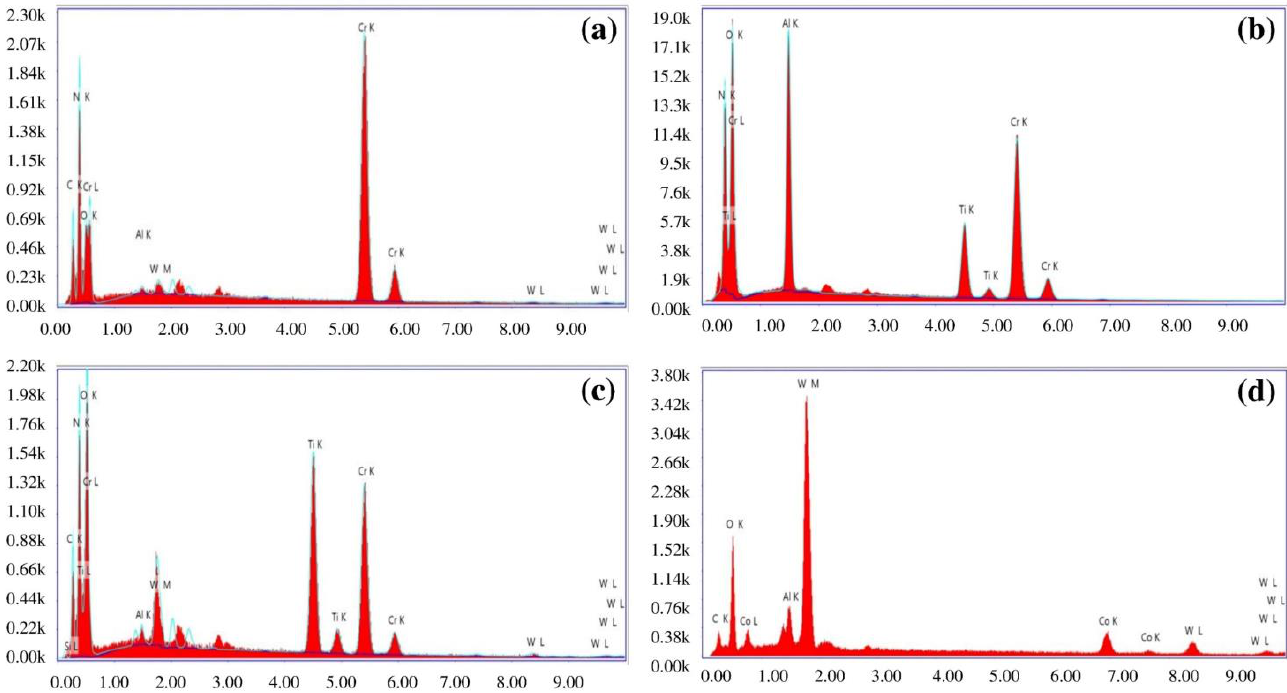
Figure 16. EDS analysis of zones A-D in Figure 15 for different coatings at the sliding speed of 50 mm/s ( a ) CrN/CrCN/DLC, ( b ) CrN/AlTiN, ( c ) CrCN/TiSiCN, and ( d ) uncoated WC-Co substrate.